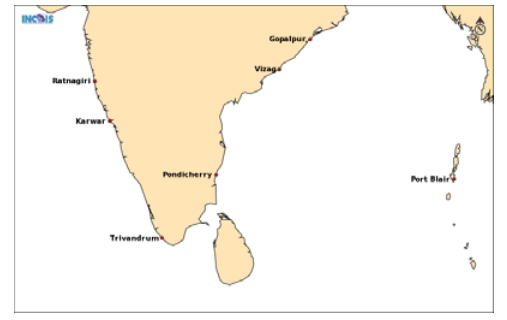
Figure 2. Locations of Wave Rider Buoys